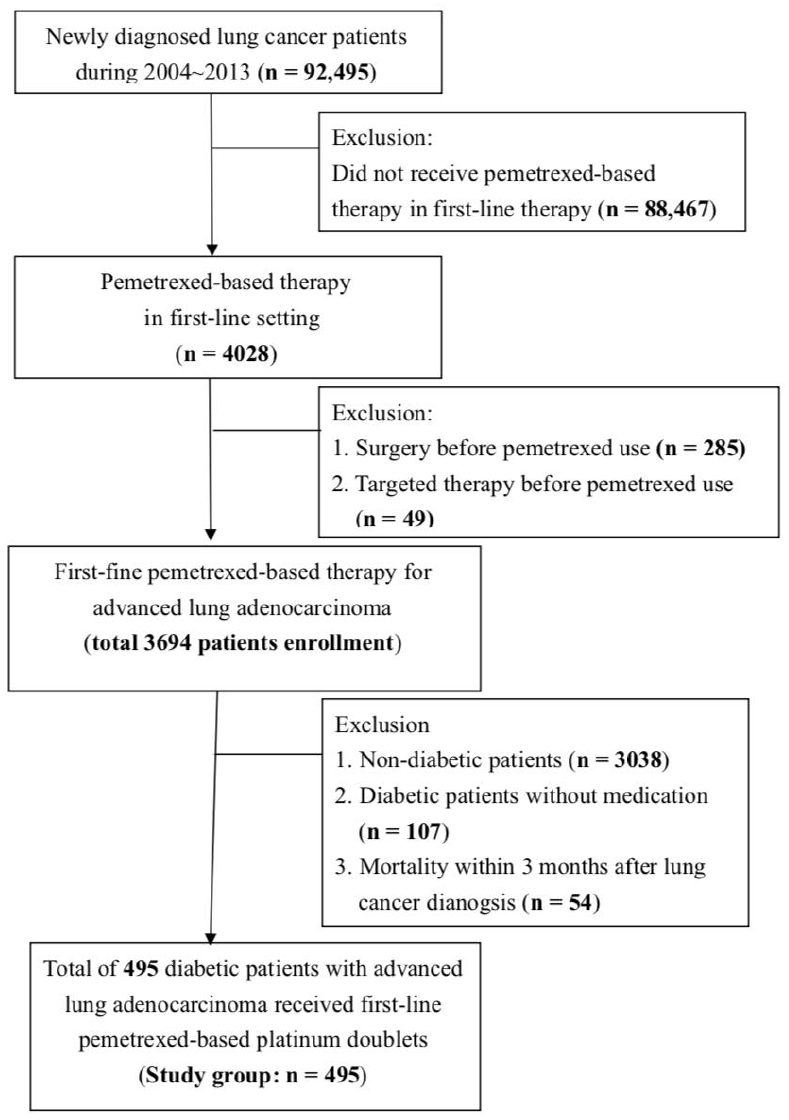
Figure 1. The enrollment flow chart of this study. Data were provided by the National Health Insurance Administration (NHIA) in Taiwan. Diabetic patients diagnosed with advanced lung adenocarcinoma receiving first-line chemotherapy with pemetrexed-based platinum doublets during 2004~2013 in Taiwan were enrolled in this study.